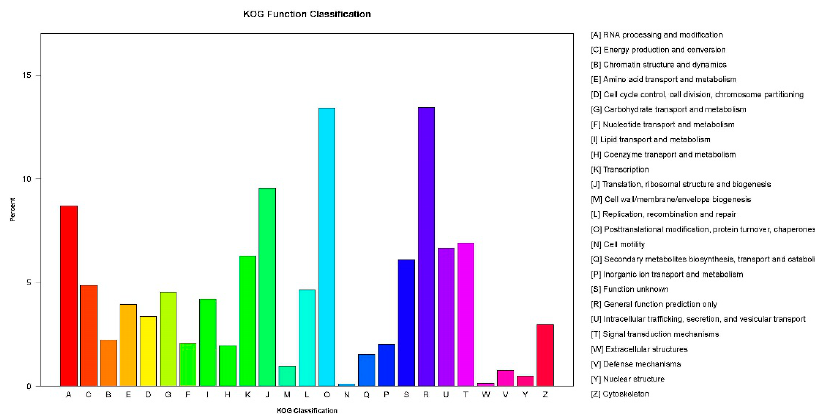
Figure 3. The euKaryotic Ortholog Groups (KOG) annotation of putative proteins. All 13,371 putative proteins assigned to KOG classification and classified into 25 molecular families.